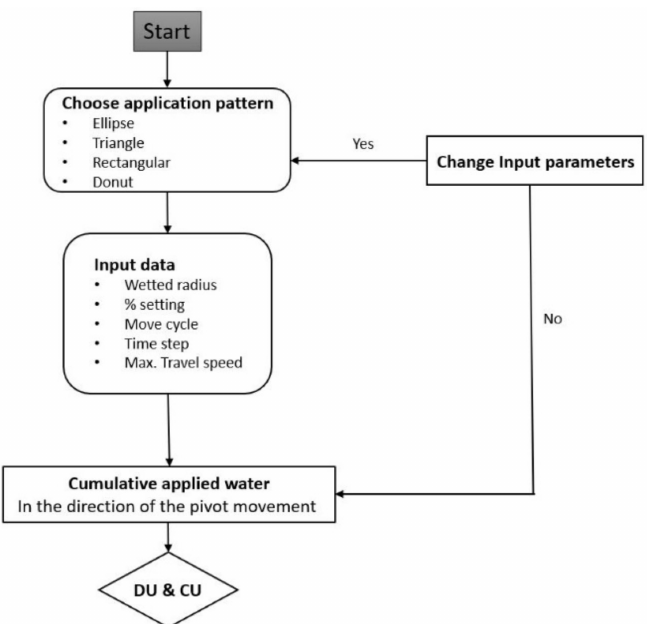
Figure 1. Stop–move model flowchart.